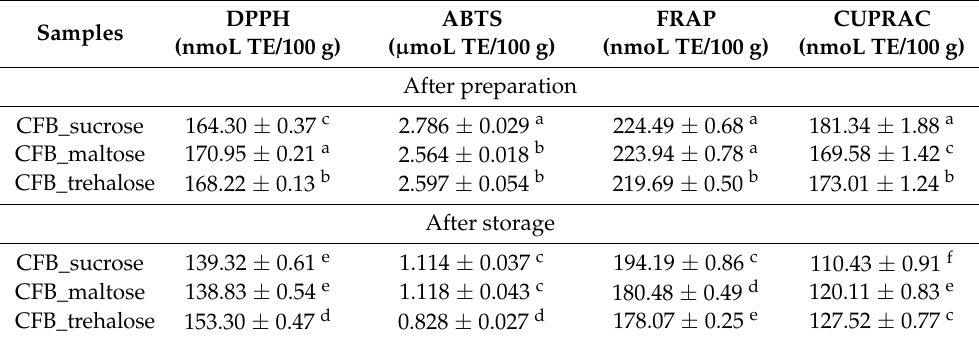
Table 2. Antioxidant activity of citrus fiber-blackberry cream fillings after preparation and after storage for 3